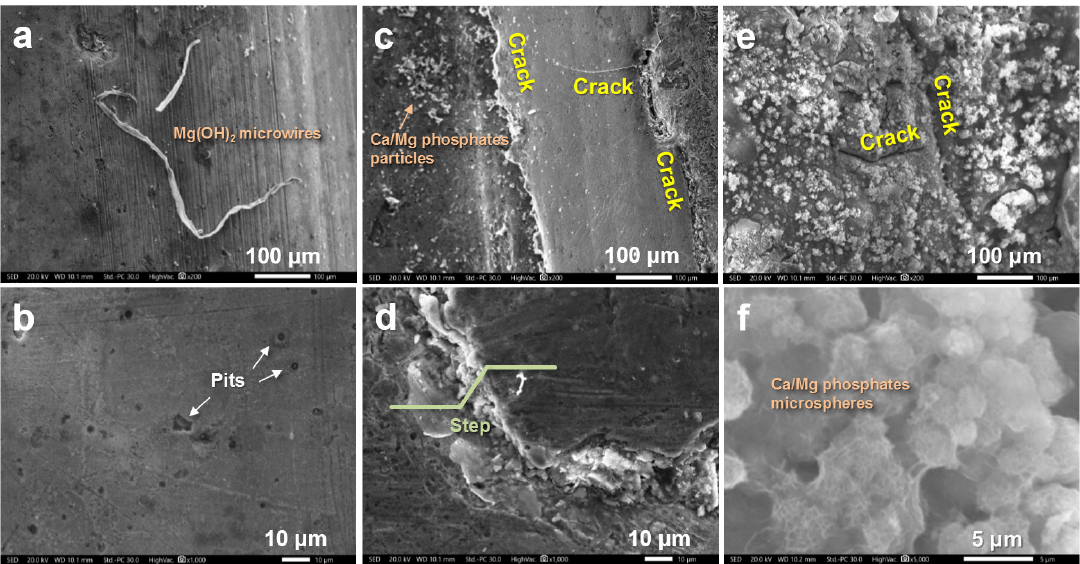
Figure 4. SEM images showing surface morphologies of Mg-Zn-Ca amorphous alloys after different interactive experiments: ( a , b ) free corrosion, Sample 6; ( c , d ) intermittent pressure corrosion, Sample 7; ( e , f ) variable pressure corrosion, Sample 8.